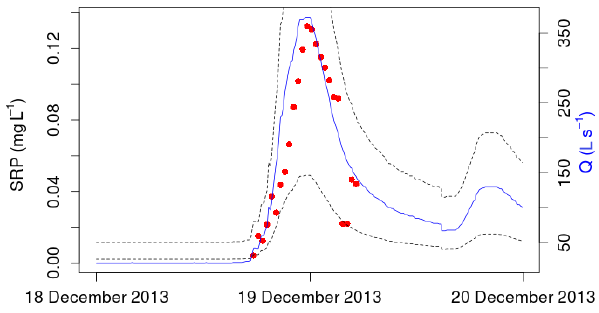
Figure 5. Example of an empirical concentration – discharge model; acceptability bounds derived from 90% prediction interval. Red circles represent the SRP